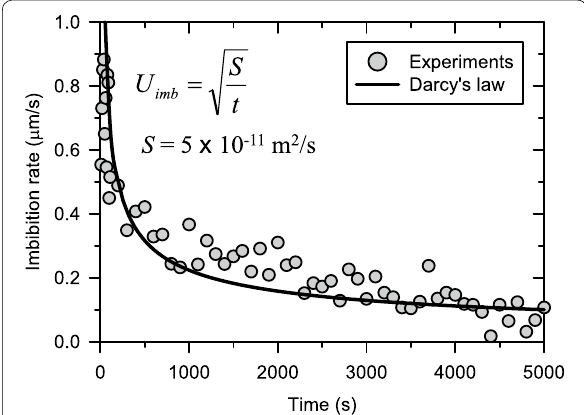
Fig. 2 The velocity graph of measured imbibition through Nafion (symbols) and regression curve derived from Darcy’s law. U imb is the imbibition velocity, t is the time, and S is the absorbing